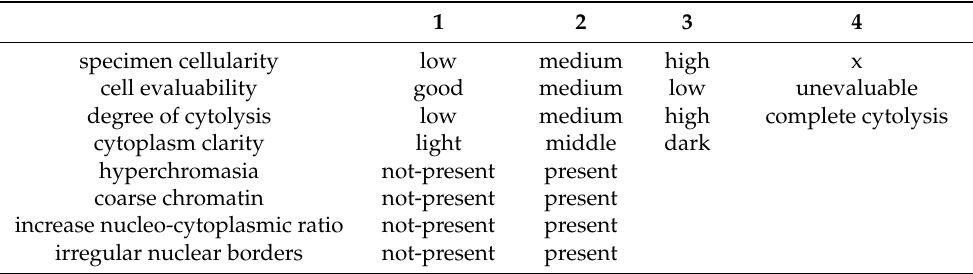
Table 1. Evaluation of other cytological